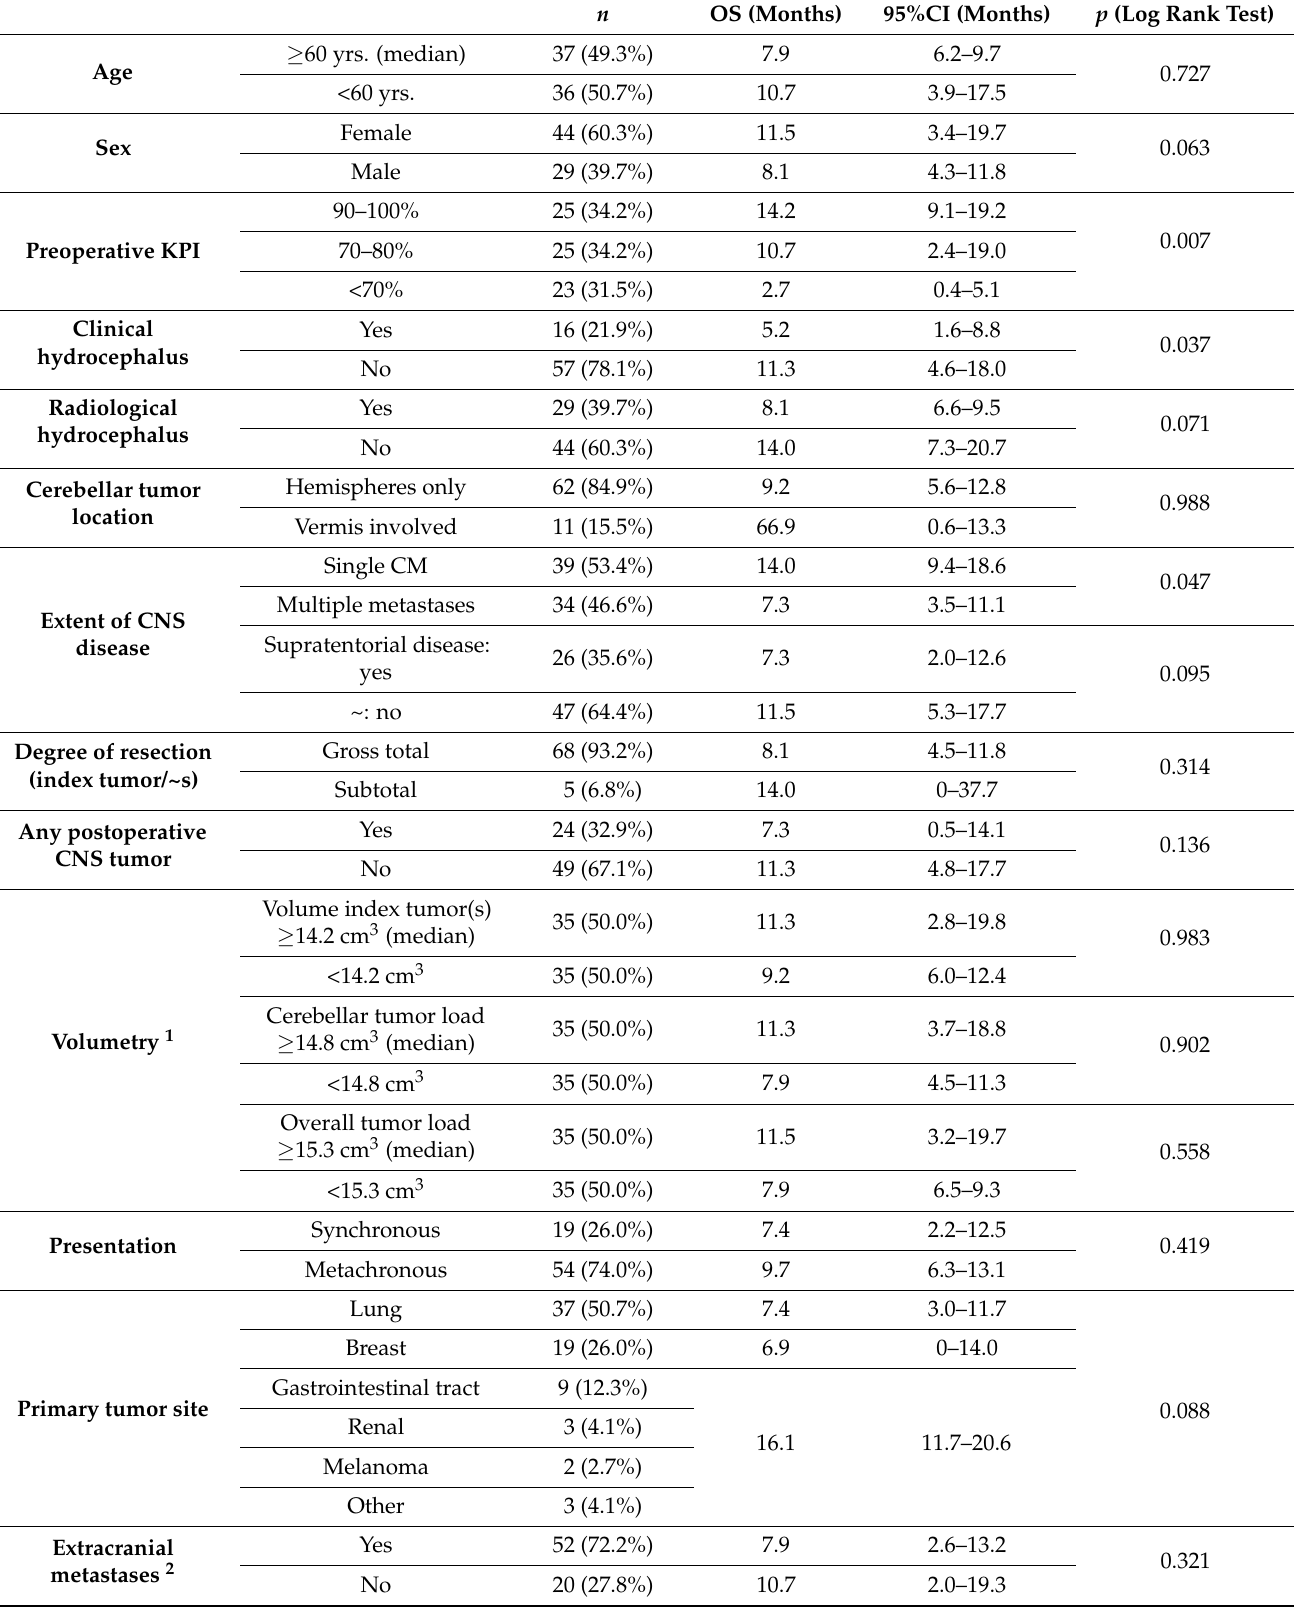
Table 2. Patient and metastases characteristics as possible predictors of patient